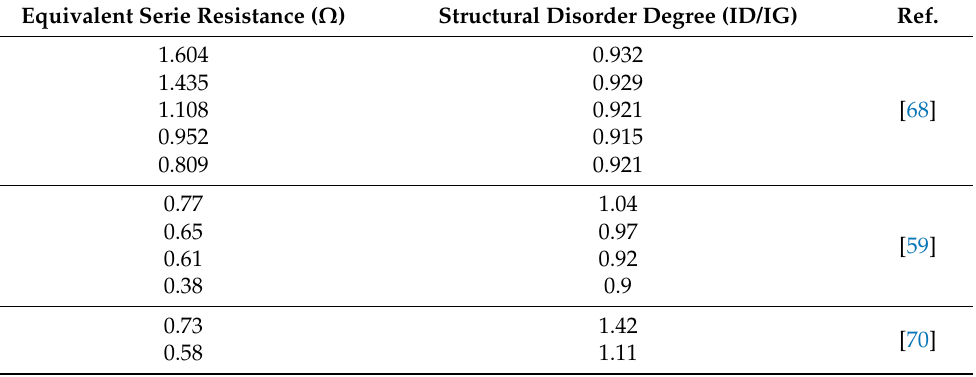
Table 3. Variation in ESR of EDLC cells with the change in structural disorder degree (ID/IG) of activated carbon